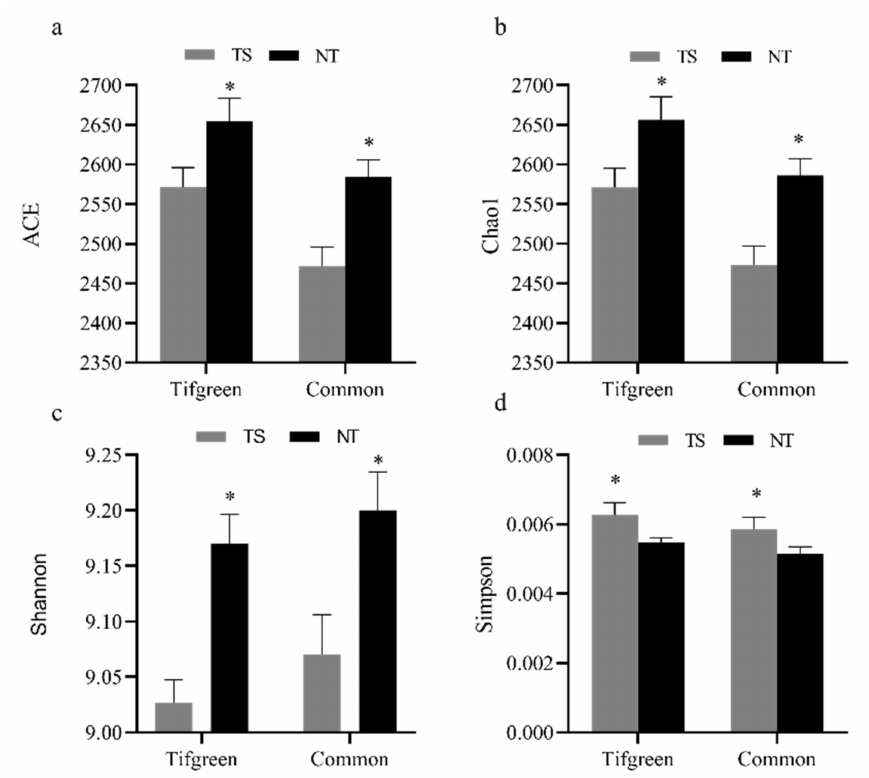
Figure 5. Alpha diversity index of soil bacterial community structure under traffic stress. ( a ) ACE index, ( b ) Chaol index, ( c ) Shannon index, ( d ) Simpson index. Note: * p < 0.05 under diverse treatments. TS: traffic stress; NT: non-traffic stress.